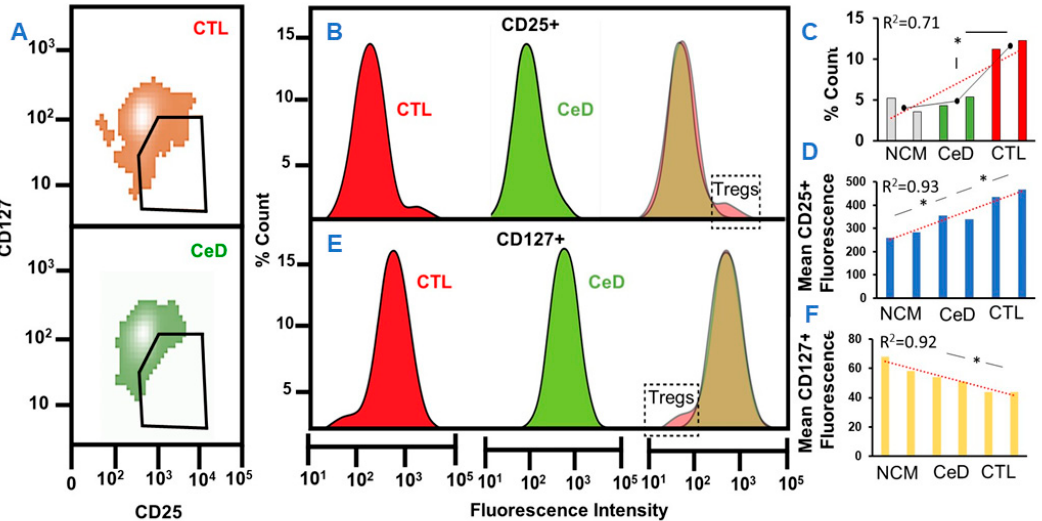
Figure 4. T cells exposed to CGM from CeD elicit compromised induction to Tregs (T—regulatory cells) compared to CTLs. ( A ) Median fluorescence intensity of CD127 versus CD25 in T cells exposed to CGM from CTL or CeD with gating shown. ( B ) Curved flow cytometric histograms (CFCHs) of CD25-labeled T cells showing increased percentage count of Tregs/total T cell population, 6 days after exposure to CGM from healthy CTL-MoDCs (red) compared to CGM from CeD-MoDCs (green). Overlap of CFCHs indicating upregulated CD25 Treg profile within CTL group (dashed outlined box). ( C , D ) Histograms of percentage count of Tregs/T-cell population ( C ) and mean fluo- rescence intensity of CD25 T cells exposed to non-conditioned media (NCM), CGM from CTL- MoDCs or CeD-MoDCs ( D ). ( E ) Curved flow cytometric histograms (CFCH) of CD127-labeled T- cells showing increased percentage count of Tregs/total T-cell population, 6 days after exposure to CGM from healthy CTL-MoDCs (red) compared to CGM from CeD-MoDCs (green). Overlap of CFCHs indicating downregulated CD127 Treg profile within CTL group (dashed outlined box). ( F ) Histograms of mean fluorescence intensity of CD127 T cells exposed to non-conditioned media (NCM), CGM from CTL-MoDCs or CeD-MoDCs. Trendline (red dashed line); mean value per group (black dots). R 2 provides fitness to the linear curve value. * p ≤ 0.05.